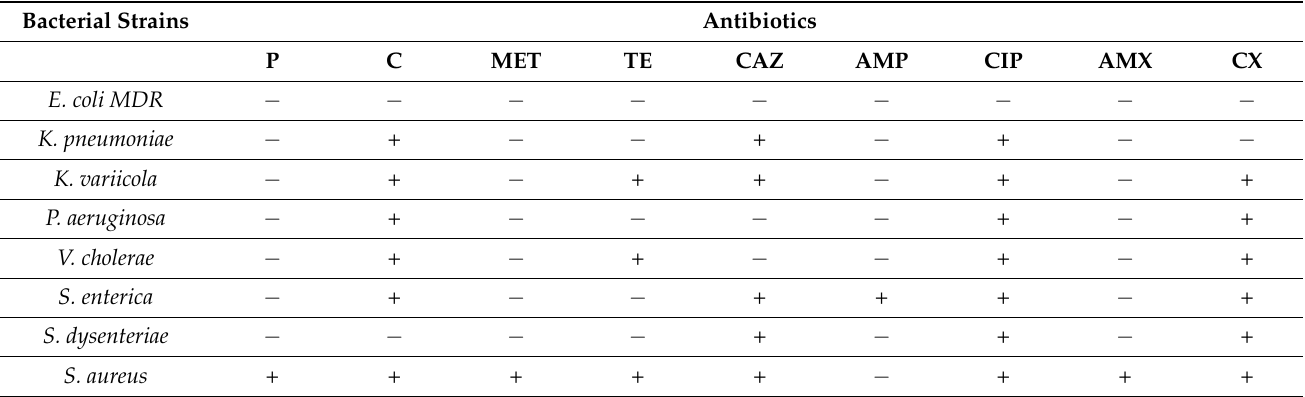
Table 1. Antibiotic sensitivity profile